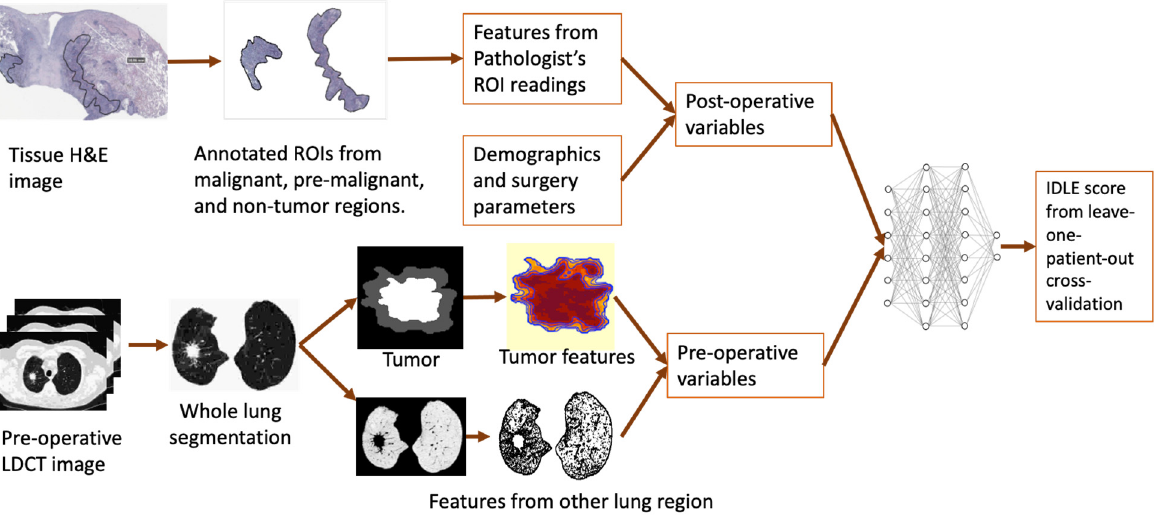
Figure 2. Study procedure. Postoperative variables include surgical tissue features extracted from pathologist’s readings, patient demographics, and surgical parameters. Preoperative variables include CT image features extracted from the tumor region, the peritumoral region, other area of the lung, and the time interval between preoperative LDCT lung scanning and surgery. All these variables were used as input variables in the leave-one-patient-out cross-validation IDLE score computation.